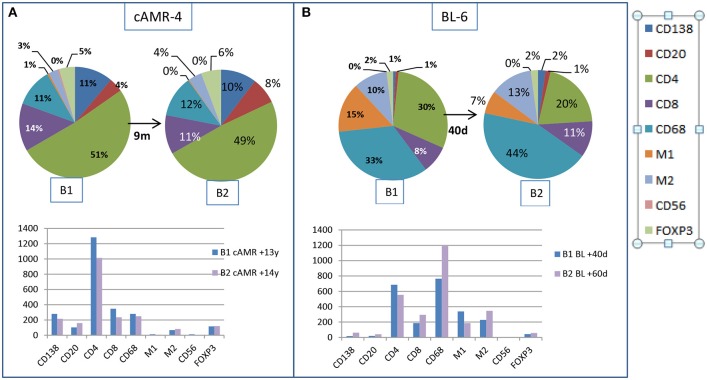
Changes in the interstitial infiltrates over time. Comparison of the amount of cells between two consecutive biopsies from a patient with cAMR (A) and a patient with BL diagnosis (B).